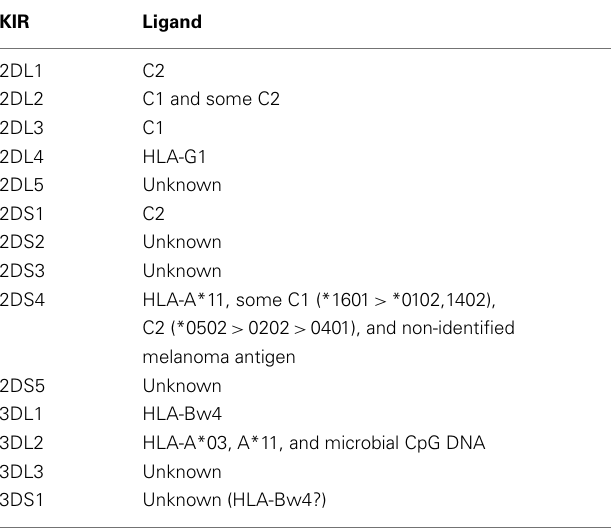
Table 1 | Ligands of KIR molecules (based on Kusnierczyk, 2006; Graef et al., 2009; Campbell and Purdy, 2011; Parham et al., 2012b; and references therein,